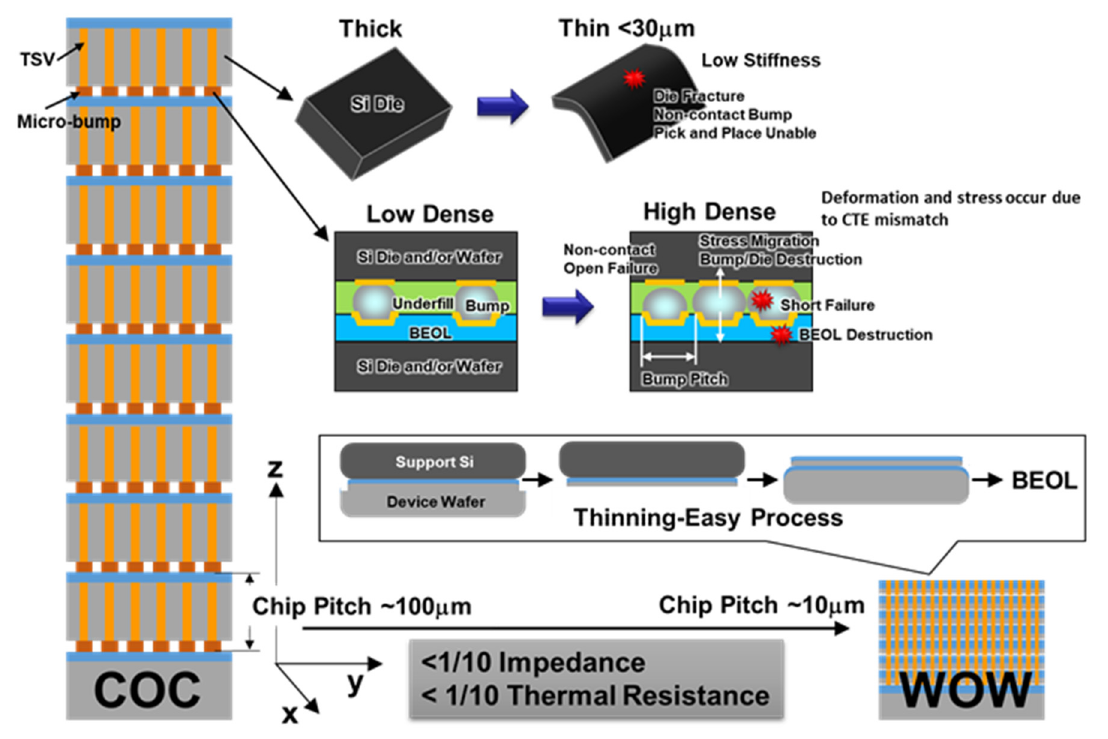
Figure 1. A comparison of bump and bumpless interconnects using TSVs for 3D logic/memory stack structures, assuming eight dies for a memory stack and one logic controller. Since the thickness of the die and density of bumps are limited by mechanical and process difficulties, chip pitch becomes as large as approximately 100 µ m, in accordance with the die thickness and bump height. Shortened bumpless interconnects can be formed with higher density (narrower pitch) compared with TSVs and bumps due to the limitations of bump size and pitch. By using wafer thinning and bumpless interconnects, the chip pitch becomes about 1/10, and impedance and thermal resistance become less than 1/10 due to the absence of bumps characterized by high electrical and thermal resistance.